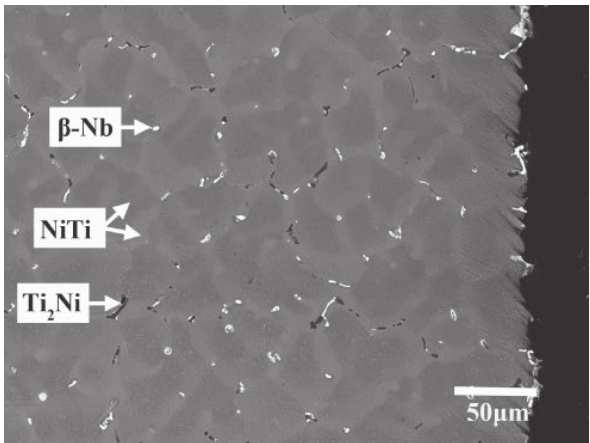
Fig. 3: Metal-crucible interfacial microstructure of the ingot in the case of using Y